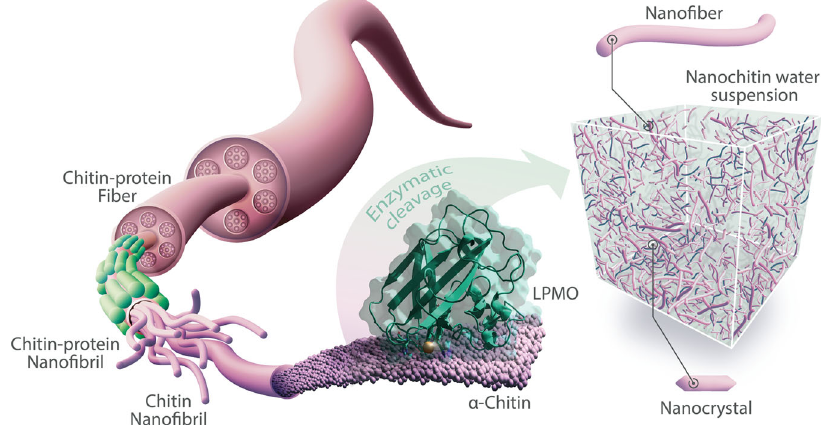
Fig. 1 Illustration of α -Chitin enzymatic oxidative cleavage. The hierarchical structure of chitin allows deconstruction into nanoscale particles. To obtain chitin nanoparticles enzymatic oxidative cleavage was performed in natural α -Chitin. Here, we represent how LPMO af fi nity to chitin fi bers catalyses these fi ber degradations into smaller fi bers. Controlling cleavage time, we can obtain nanochitin with different sizes. Chitin nanocrystals (CNCh) are small crystalline particles with lengths between 100 and 500 nm and diameters between 3 and 40